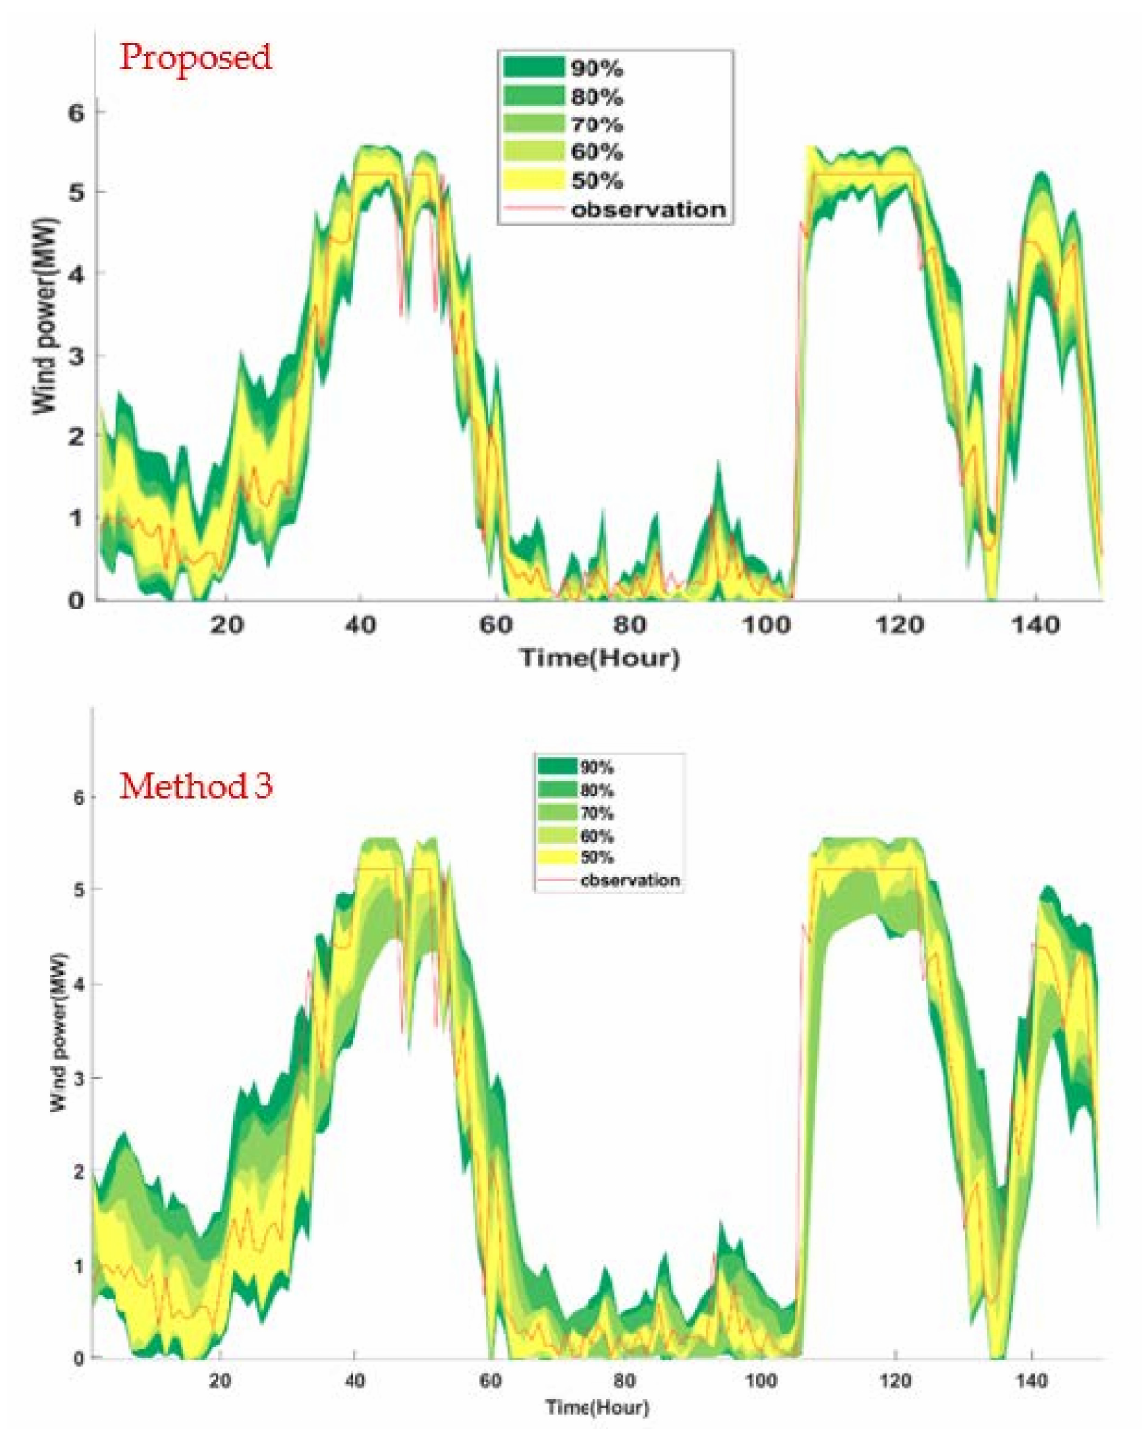
Figure 16. Comparison of wind power forecasting results by the proposed method and Method